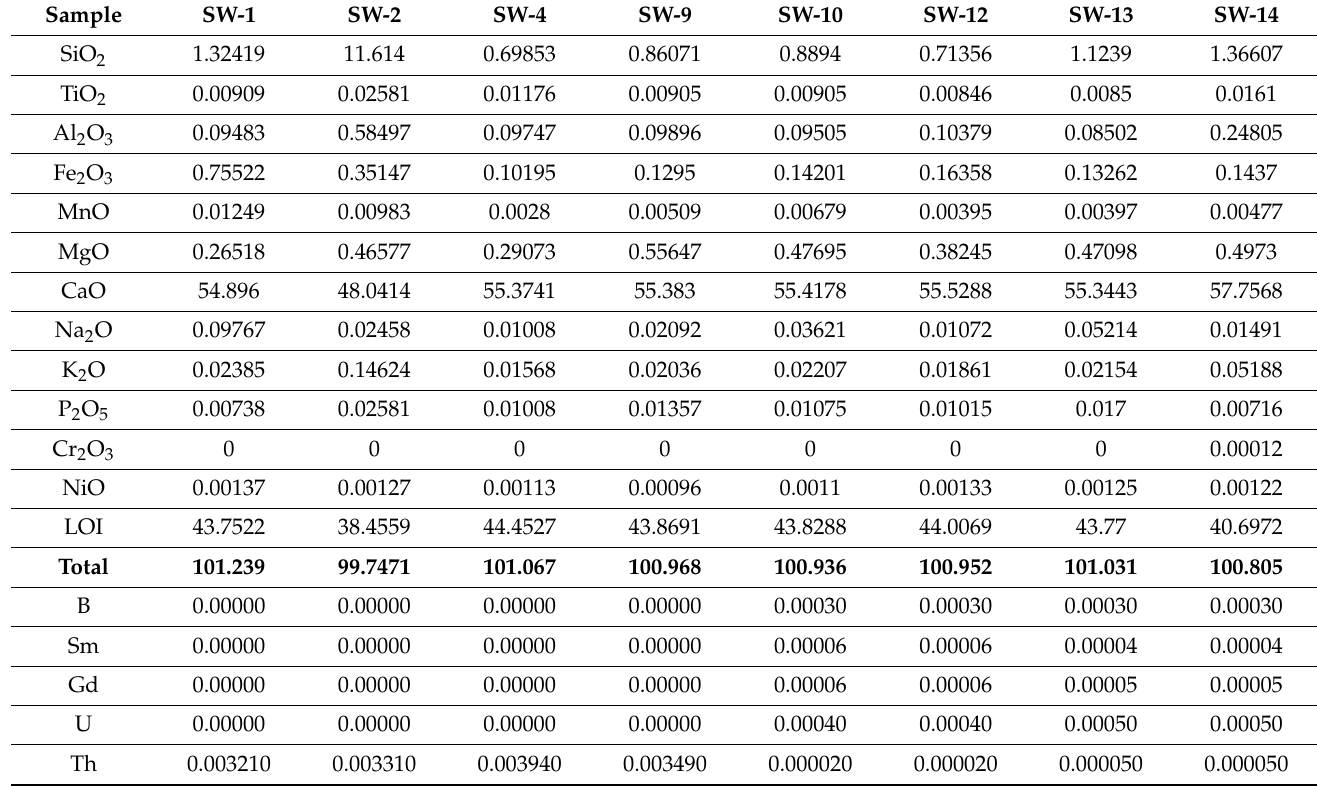
Table A1. XRF results for chemical compounds with LOI corrected values and trace elements with LOI corrected values used in the age